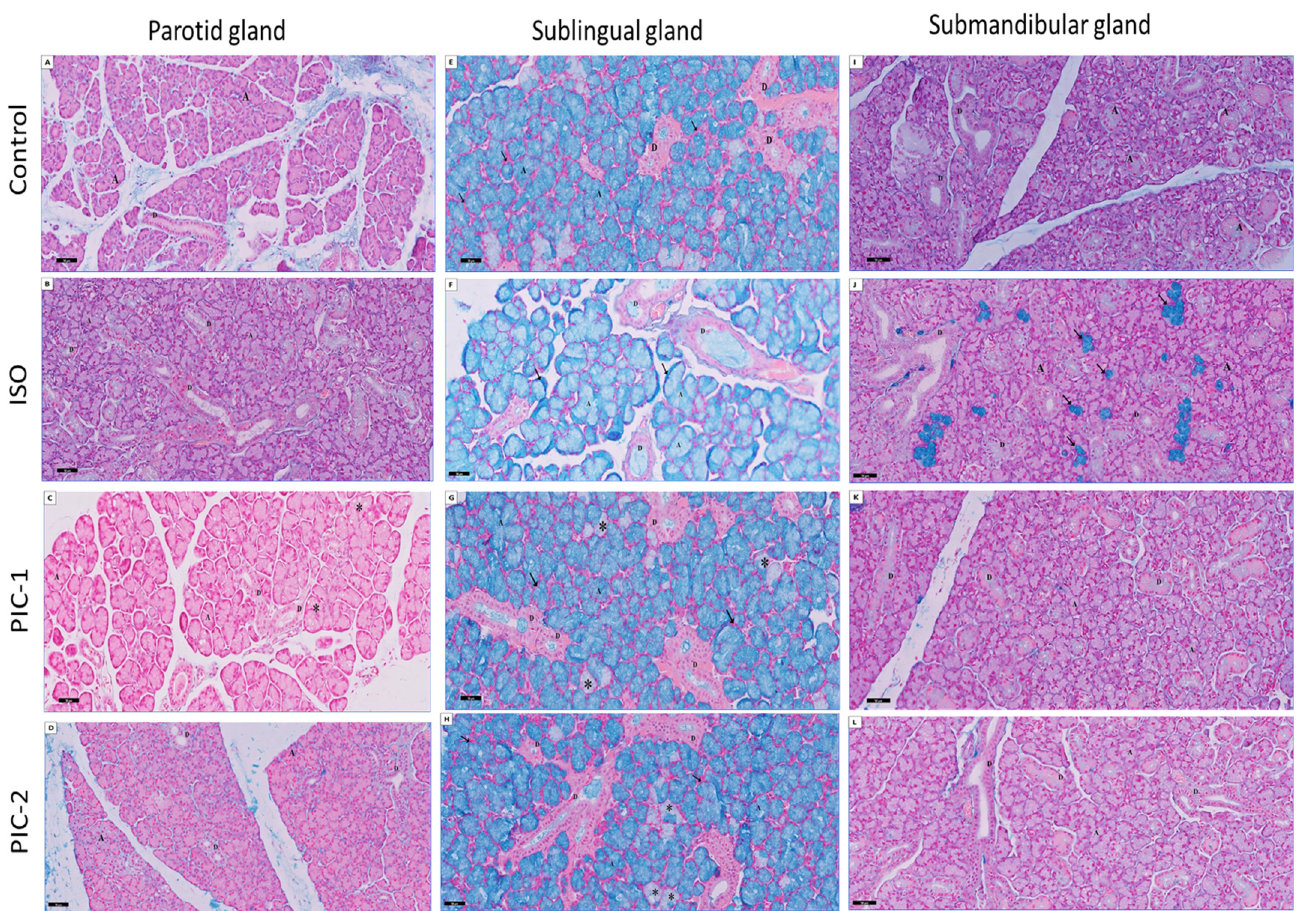
Figure 6. Sections of the three salivary glands (parotid ( A – D ), sublingual ( E – H ), and submandibular ( I – L ) glands) are stained with Alcian blue for acidic glycoconjugates and counterstained with Nuclear Fast red. Control group strong positive acidic mucin sky-blue reaction in the secretory acini (A) and the lumen of ducts (D) in the sublingual gland with a negative reaction in the serous demilune ( ↑ ) and negative reaction in the parotid gland. While submandibular gland showed a negative reaction with faint sky-blue color inside the acinar cells. The ISO treated group shows a faint positive acidic mucin sky-blue reaction in the sublingual secretory acini and the lumen of ducts and a strong positive reaction in the serous demilune. The parotid gland shows a negative reaction with faint sky-blue color inside the acinar cells. The submandibular gland shows a blue positive reaction ( ↑ ) in the acinar cell’s cytoplasm. The duct epithelial cells show a strong positive reaction for the secretory granules and the epithelial lining. The PIC-1 group shows strong positive acidic mucin sky-blue reaction except for few acinar cells with faint (*) positive reaction. A negative reaction is shown in most of the acini and ducts of the parotid gland while submandibular gland shows negative reaction in most of the acinar cells. The PIC-2 group appears similar to the control group (Alcian blue; ×200).